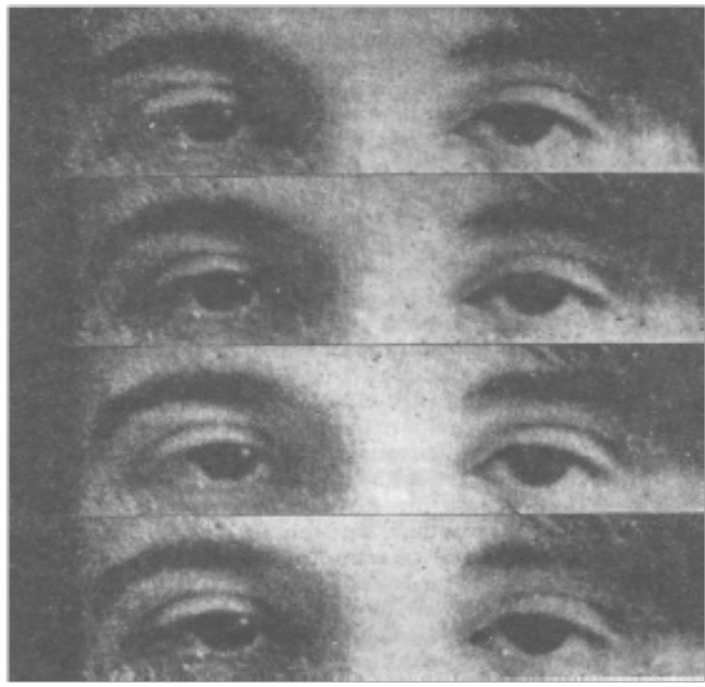
Figure 5. Anonymous. Ses yeux de fougère in Nadja